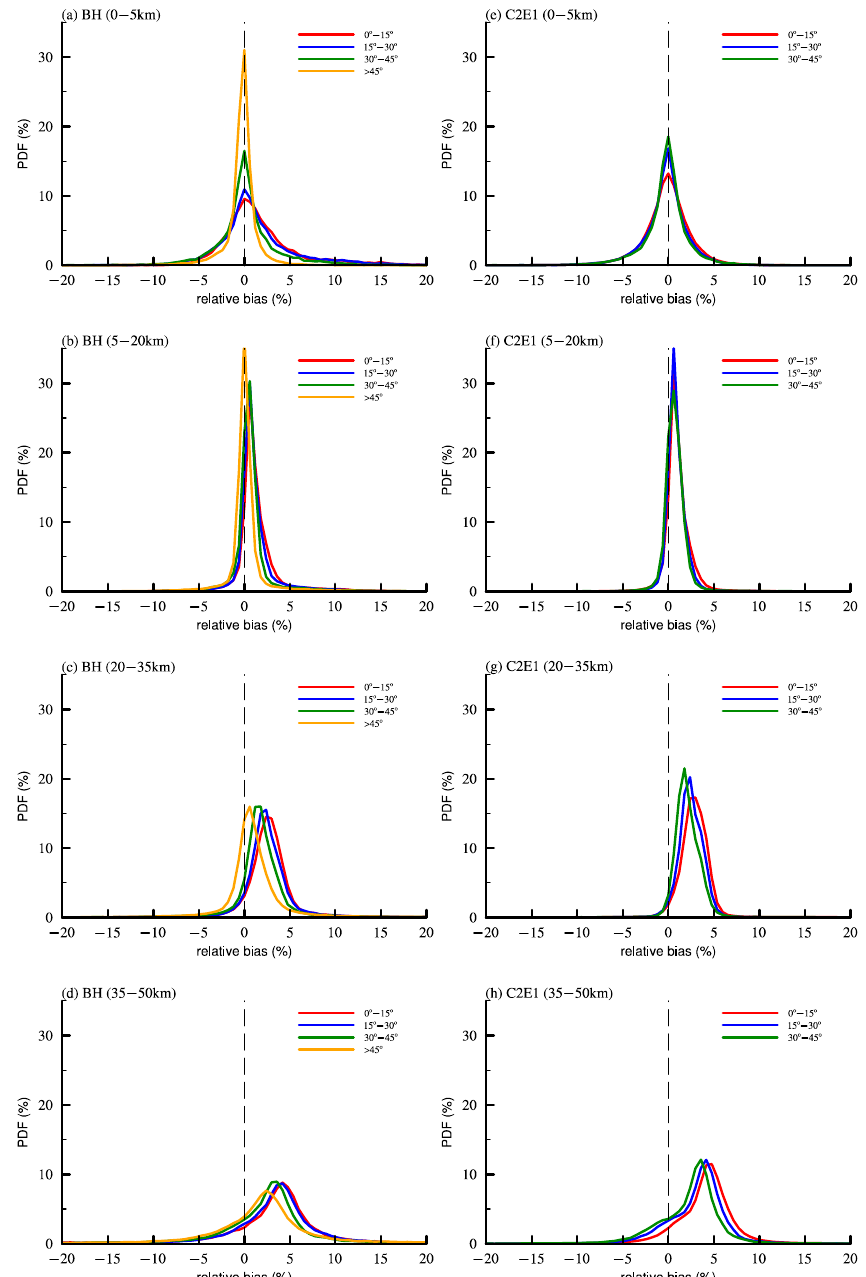
Figure 6. The probability density function (PDF) of the relative bias for BH and C2E1 at different heights. Refractivity data at different heights. ( a – d ) PDF for BH refractivity data at 0–5 km, 5–20 km, 20–35 km, and 35–50 km, respectively; ( e – h ) same as ( a – d ) but for C2E1 refractivity data. The red, orange, green, and blue lines indicate the mean relative bias of the refractivity in the latitude ranges of 0–15°, 15–30°, 30–45°, and 45–90°, respectively.